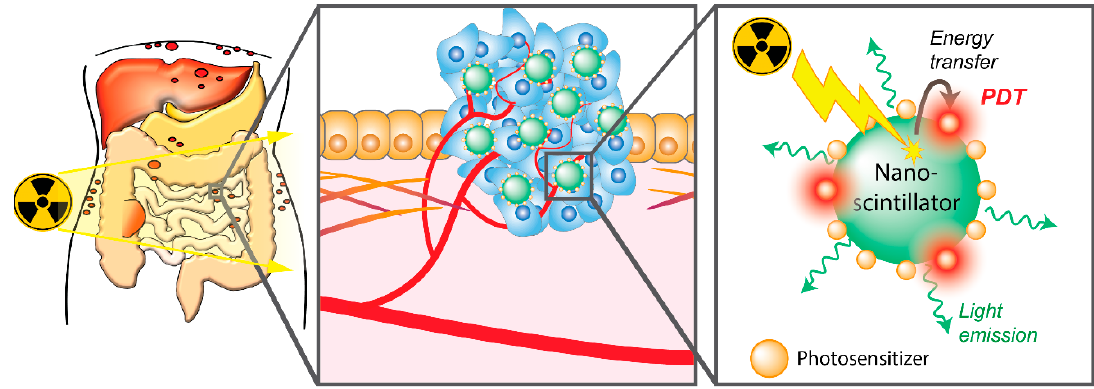
Figure 4. Schematic overview of the use of radiotherapy-activated PDT for PCAR using radioluminescent nanomaterials. Radiotherapy can be applied for whole-abdomen irradiation. Scintillating nanomaterials accumulated in the cancer tissues can absorb the X-ray radiation and down-convert it into visible light. Conjugated photosensitizers can be excited, resulting in the photodynamic production of cytotoxic reactive oxygen species.